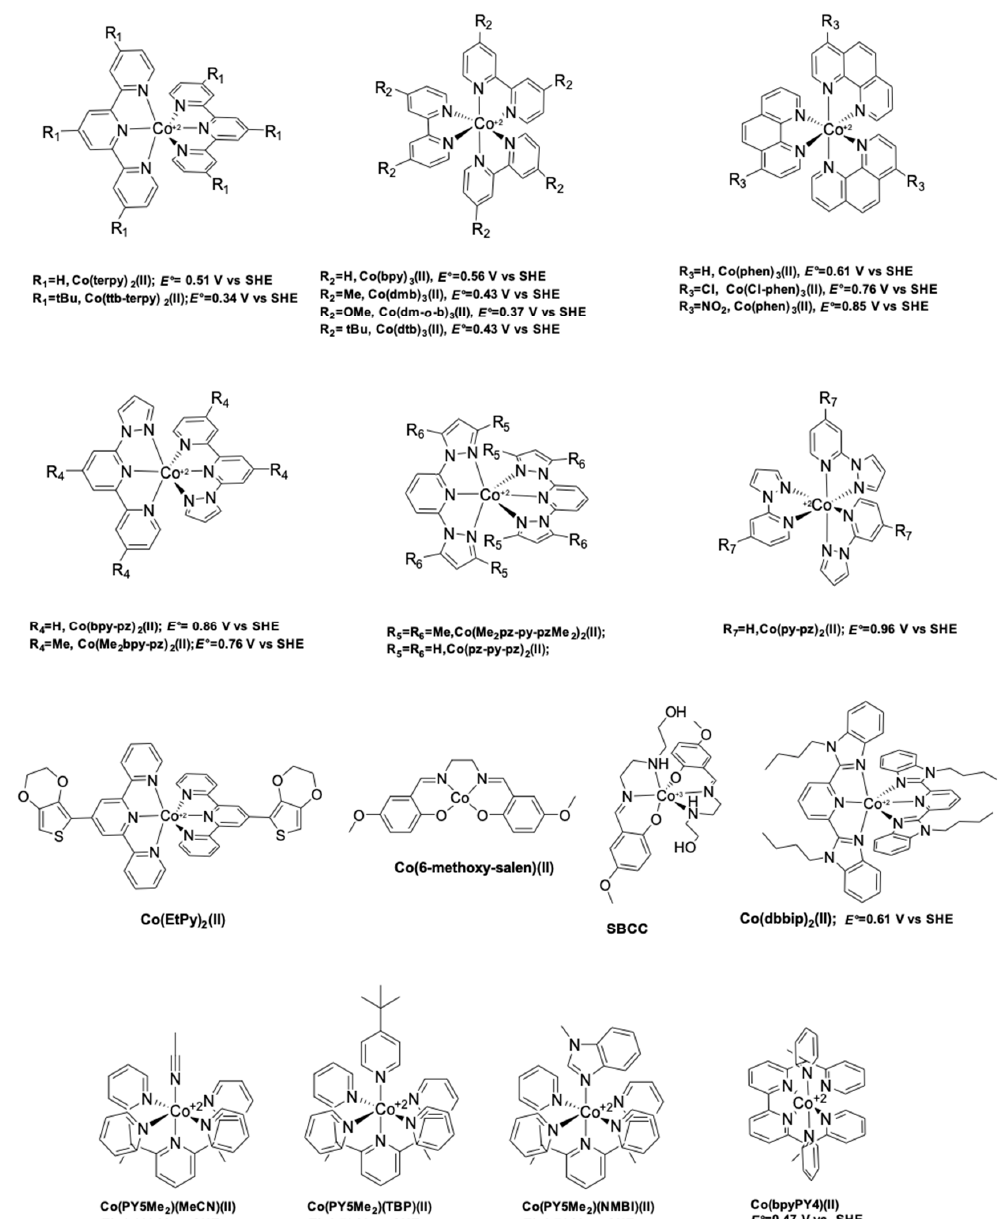
Figure 4. Chemical structure of polypyridine based cobalt coordination complexes used as redox mediators in DSSCs.